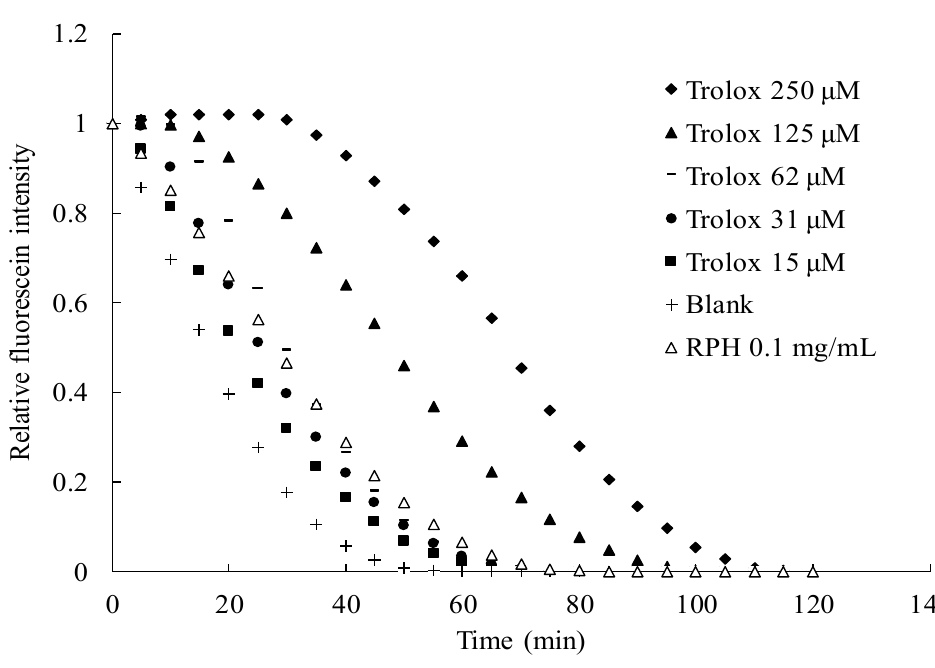
Figure 5. Fluorescence decay kinetic curve of the oxygen radical absorbance capacity assay for various samples.